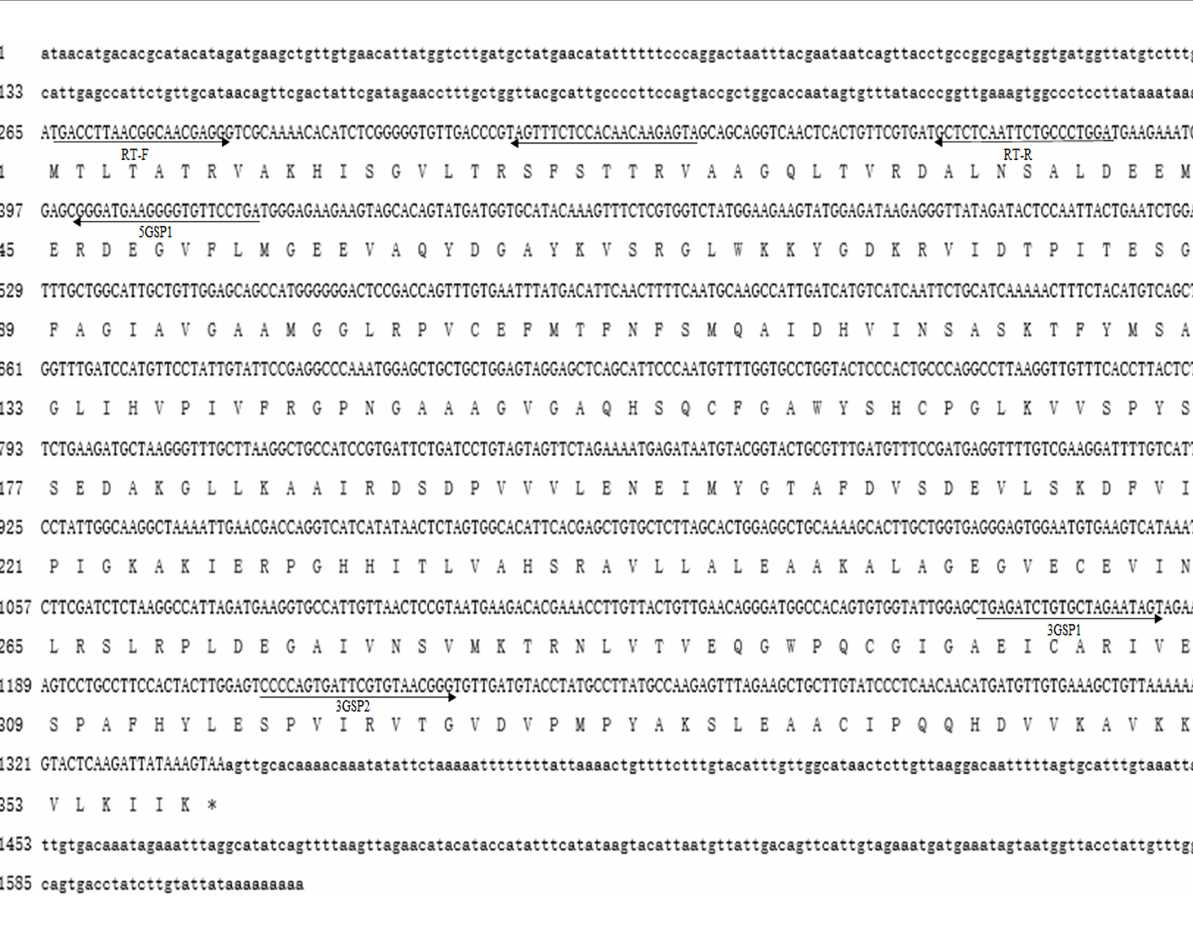
FIGURE 1 | Nucleotide and deduced amino acid sequence of Mn-PDHE1 . The nucleotide sequence is displayed in the 5 ′ – 3 ′ directions and numbered at the left. The deduced amino acid sequence is shown in a single capital letter amino acid code. 3 ′ UTR and 5 ′ UTR are shown with lowercase letters. Codons are numbered at the left with the methionine (ATG) initiation codon, an asterisk denotes the termination codon